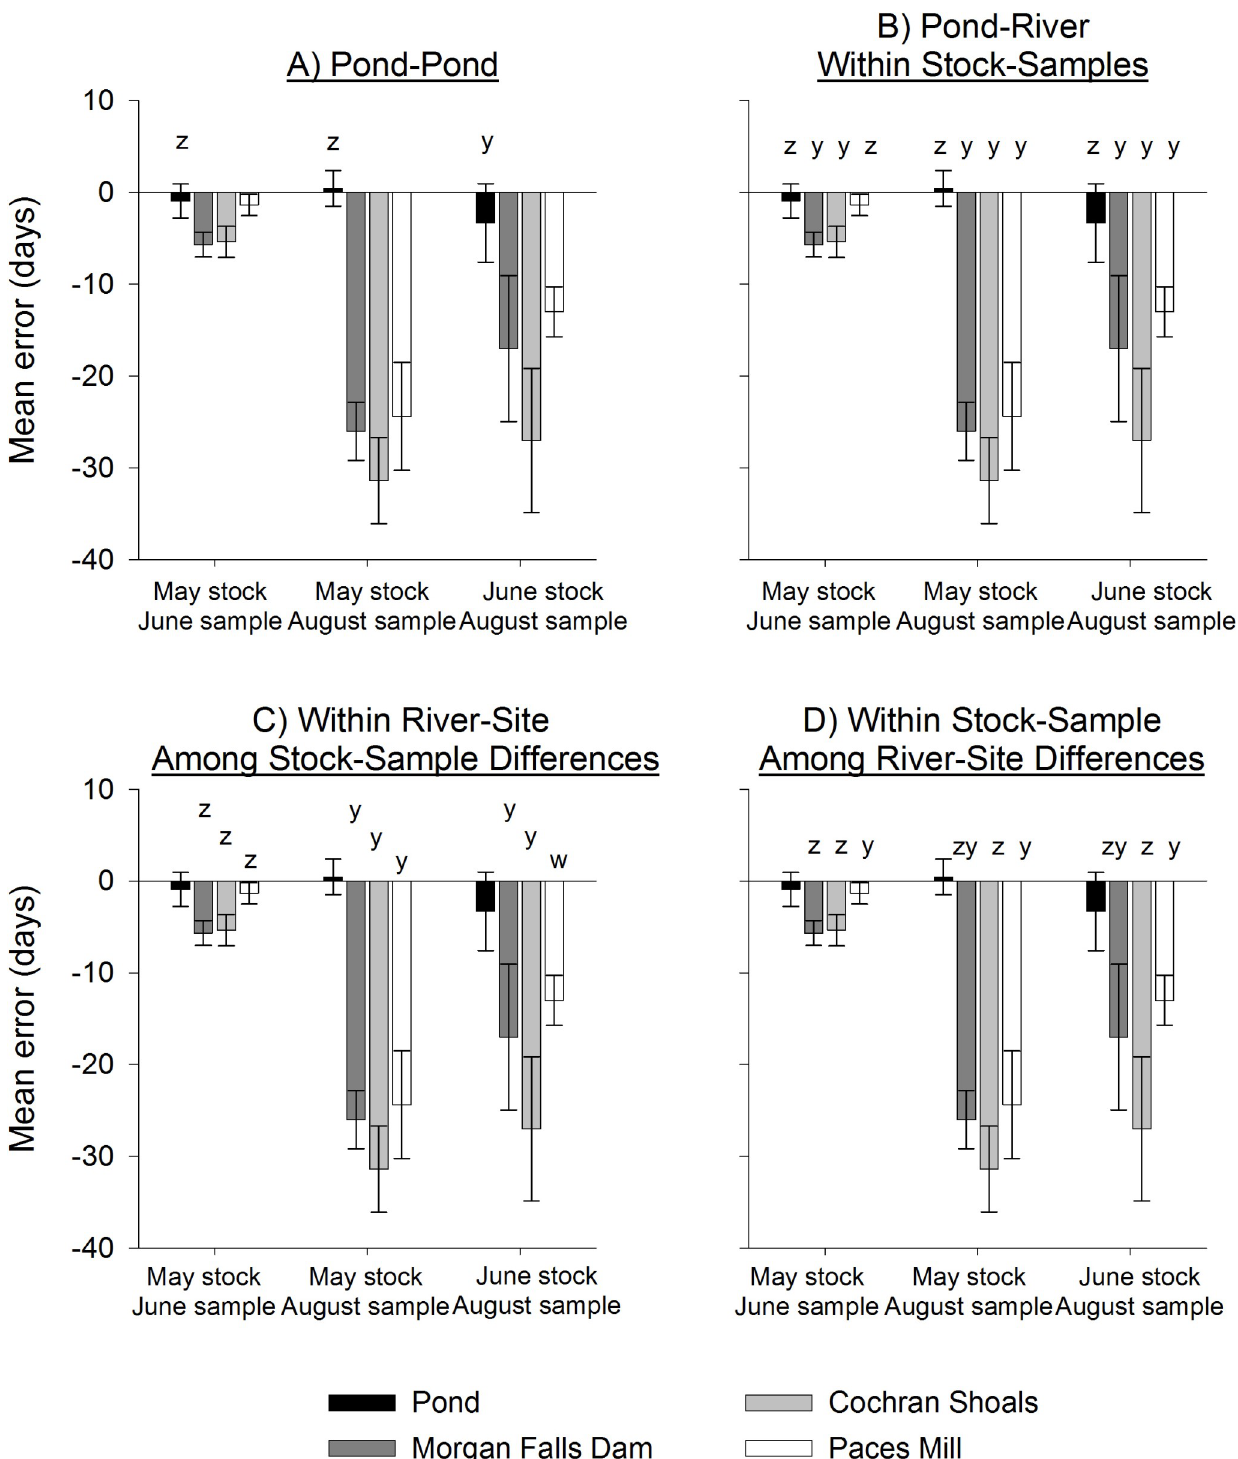
Fig 3. Mean age error (days; ± 1 SD) of juvenile Shoal Bass in different environments. The amount of age estimation error was tested among sets of environments according to time of stocking, oxytetracyline (OTC) marking (May or June) and time of sampling (June or August) in 2004. Four comparisons from a generalized linear mixed model were made: (A) pond environment among stock-sample combinations, (B) pond compared to sites in river within each stock-sample combination, (C) among stock-sample combinations for each of the three river sites, and (D) among each of the three river sites for each stock-sample combination. Dissimilar letters above the bars indicate significant differences at P � 0.05. See Fig 2 for a diagrammatic representation of stocking, OTC marking, and sampling scheme for these comparisons.